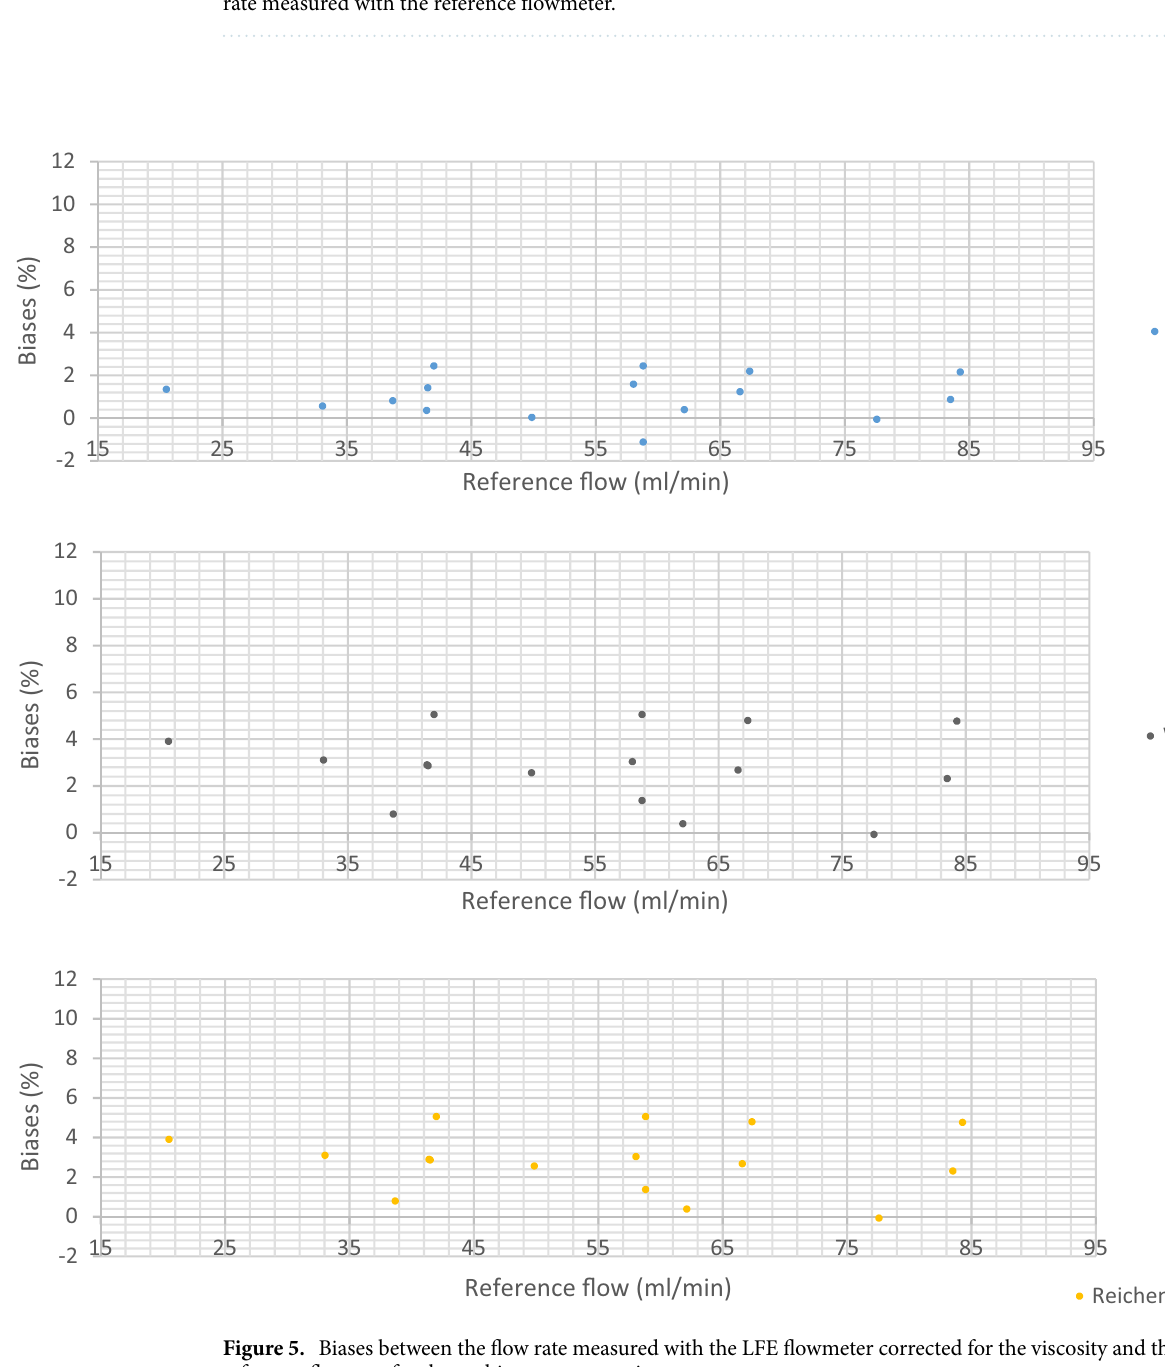
Figure 5. Biases between the flow rate measured with the LFE flowmeter corrected for the viscosity and the reference flow rate for the multi-component